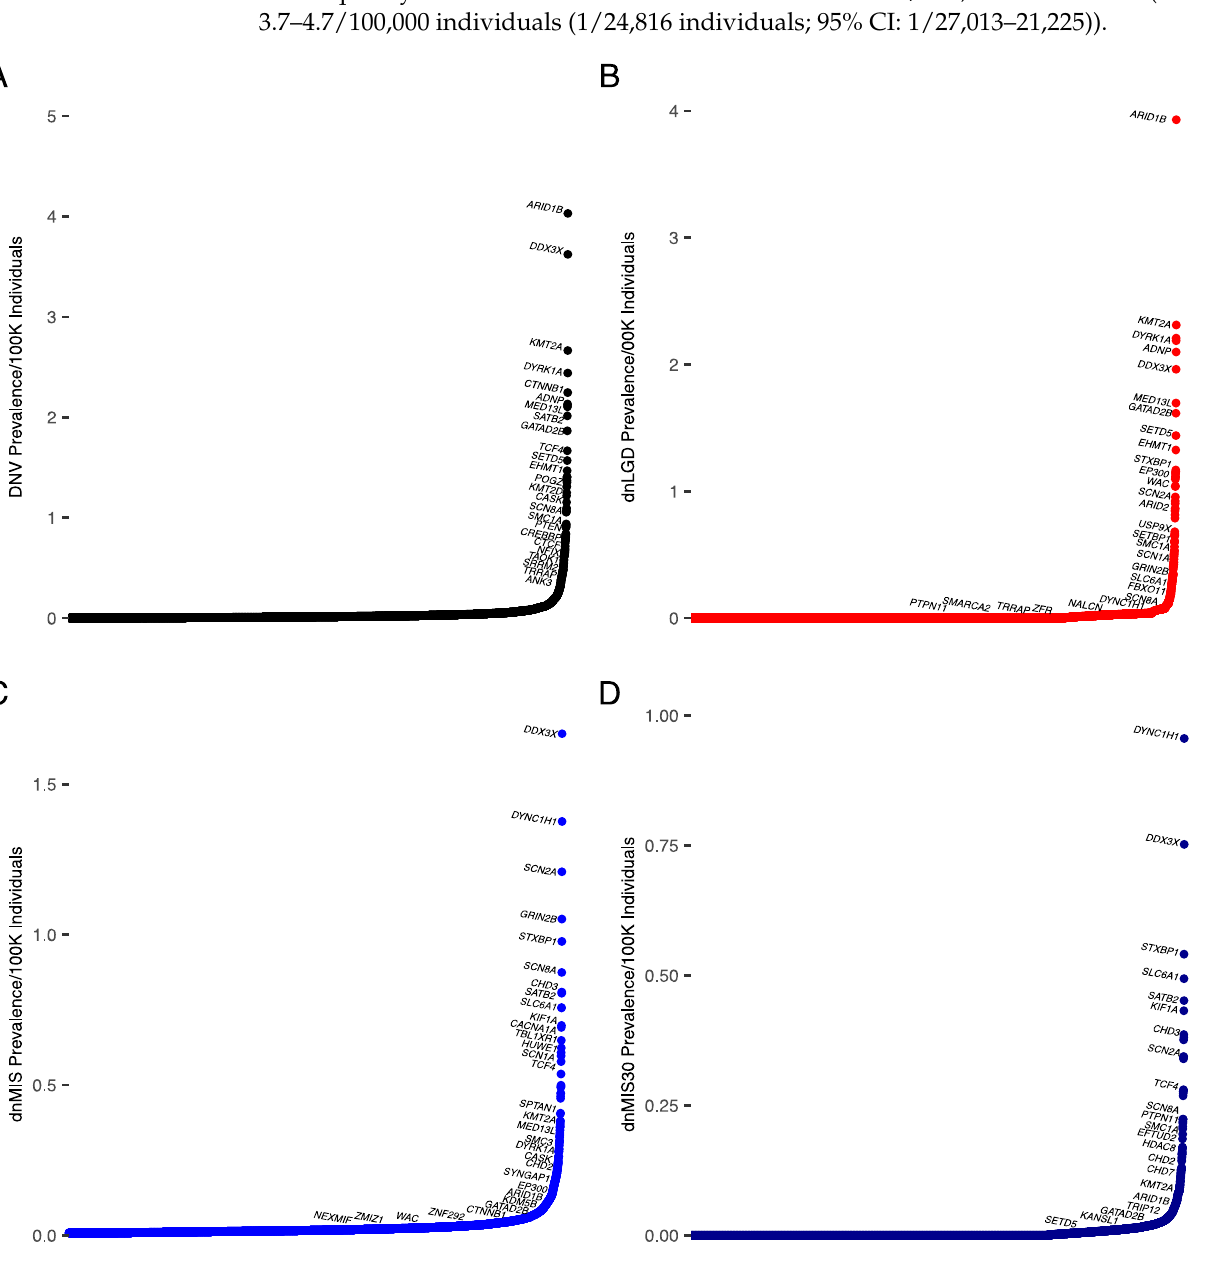
Figure 2. Prevalence of DNVs by gene extrapolated from number of cases in DD/ID cohort. Genes are indicated along the x -axis, with prevalence of each variant type on the y -axis. ( A ) DD/ID DNV cases, ( B ) DD/ID dnLGD cases, ( C ) DD/ID dnMIS cases, and ( D ) DD/ID dnMIS30 cases. The proportion of each gene and mutation type in our cohort was multiplied by the estimated prevalence of DD (DD/ID) from Zablotsky and Black, 2020.